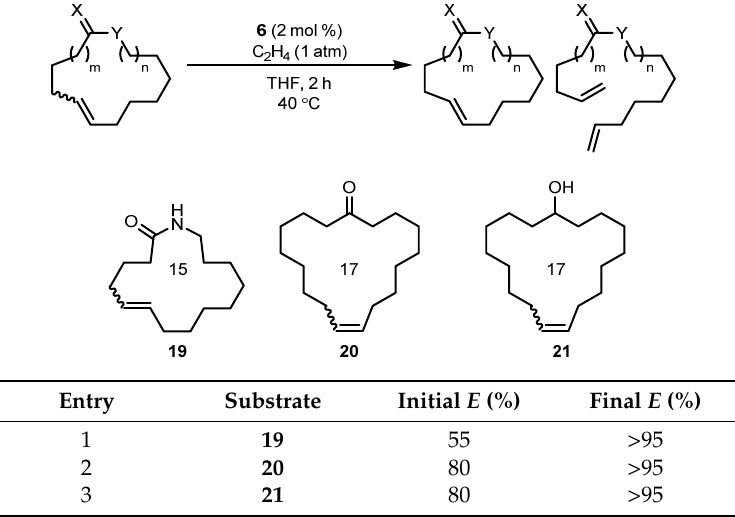
Table 5. Z -Selective ethenolysis furnishing E -isomer enriched macrocycles.